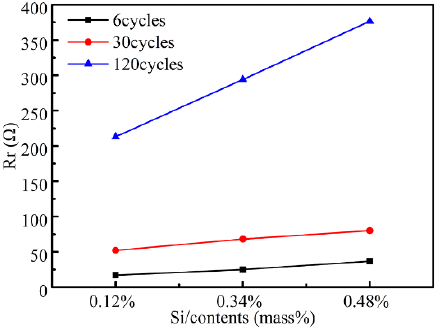
Figure 10. Relationship between Si content and resistance at 6th, 30th, 120th cycle.